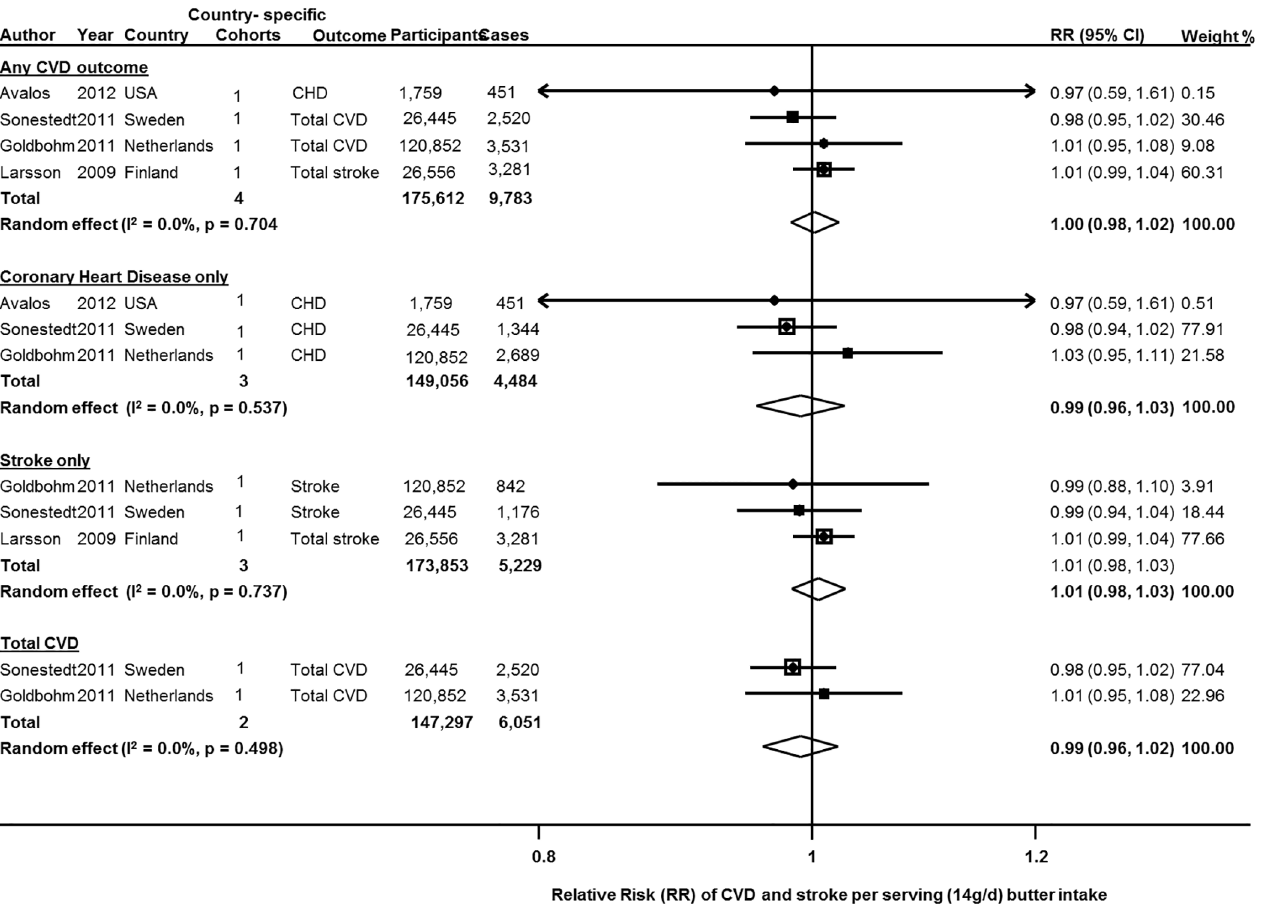
Fig 3. Butter consumption and risk of any and total cardiovascular disease, stroke only and CHD only. Data from 4 prospective cohorts with 175,612 participants and 9,783 cases for CVD, 3 cohorts of 173,853 participants and 5,299 events for stroke, and 3 studies of 149,056 participants and 4,484 cases of CHD. Within-study dose-response RRs were derived from reported linear effects or generalized least-squares trend estimation for studies reporting categories of intake, a pooled using both inverse-variance weighted random and fixed effects meta-analysis. CHD: Coronary Heart Disease; CVD: Cardiovascular Disease; D+L: DerSimonian and Laird random effects; I-V: Inverse-variance fixed effects; RR (95%CI): Relative Risk and 95% Confidence Interval.